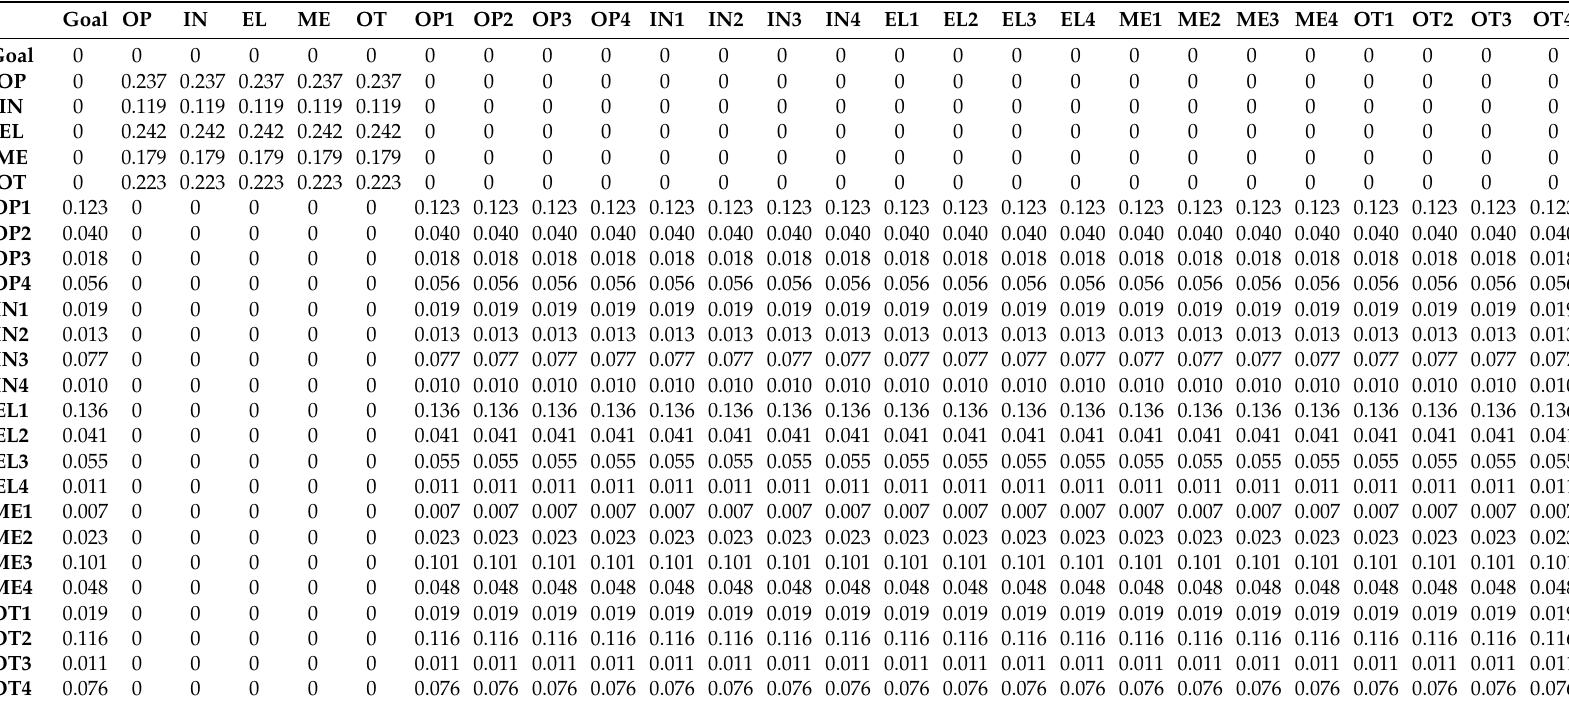
Table 12. Limited Supermatrix of Clusters and